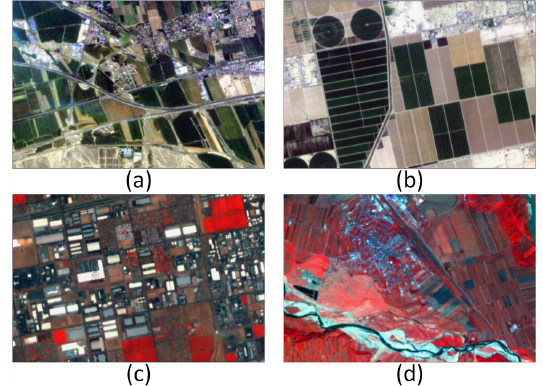
Figure 10. Color composite results of our methods in cloud-free images. (a), (b) are true-color images with band 2,7,14. (c), (d) are pseudocolor images with band